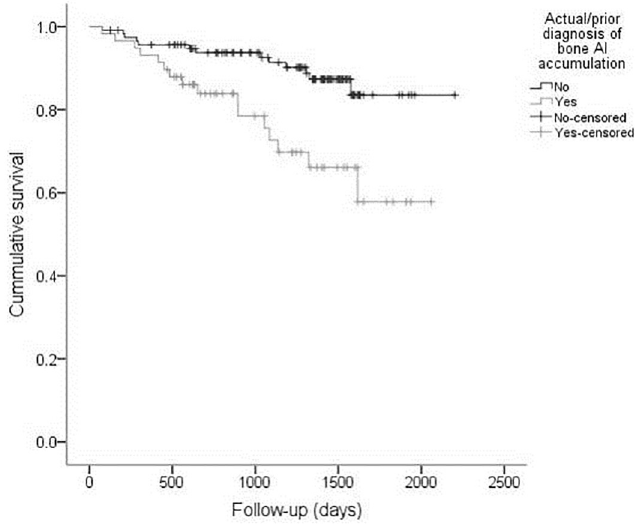
Fig 1. Kaplan-Meier curve for MACE according to actual/prior diagnosis of bone Al accumulation (log-rank; p = 0.002).